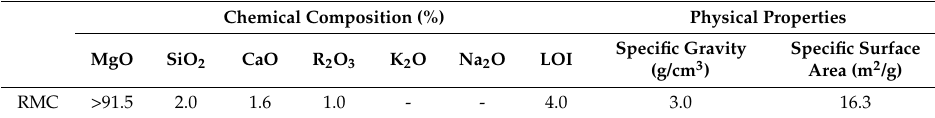
Table 2. Chemical composition and physical properties of MgO.